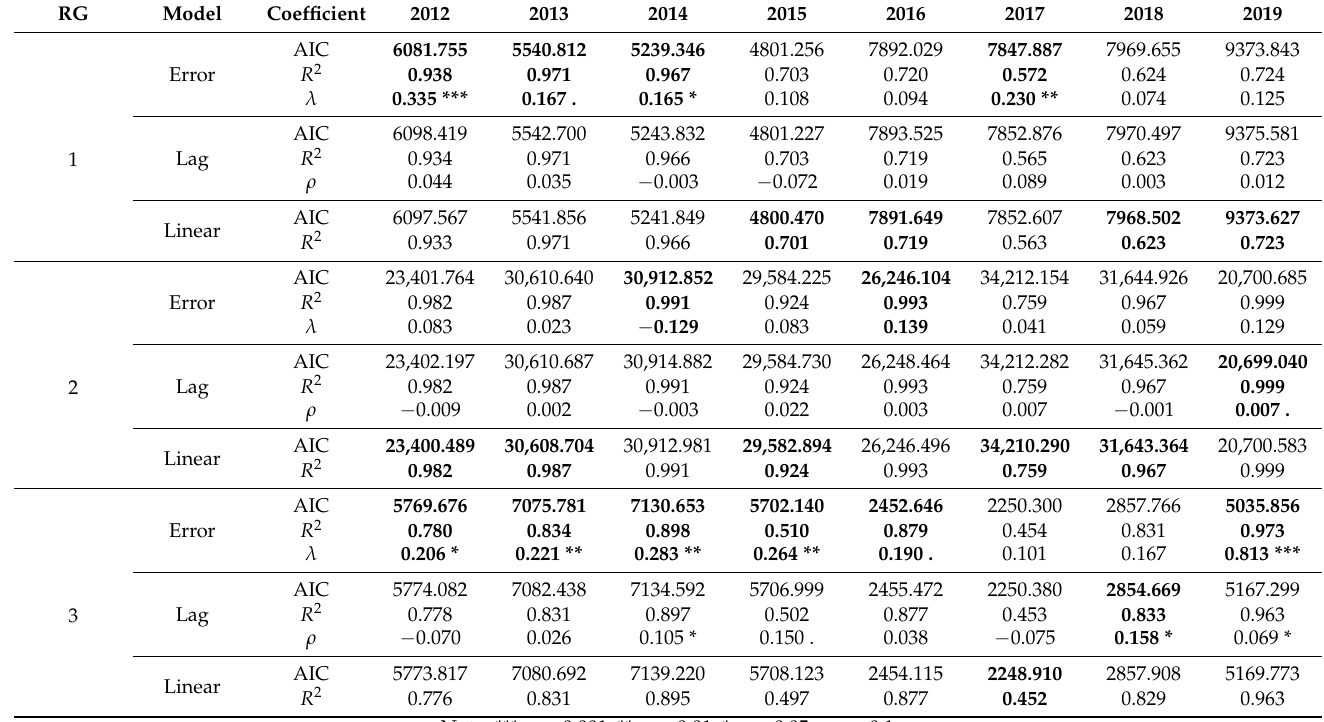
Table 4. Parameter estimates and evaluation metrics of spatial error, spatal lag and linear regression models. The best models per year and representativeness group are highlighted in bold. RG 1, 2 and 3 are short for the underrepresentation, medium and overrepresentation